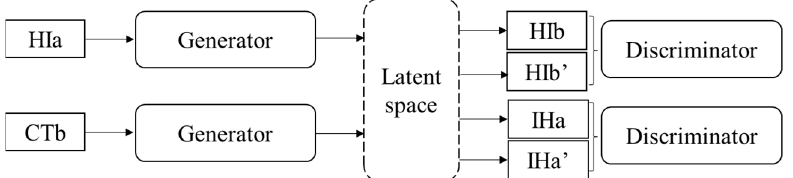
Figure 12. The architecture of XNet. HIa and CTb refer to a halftone image and a continuous-tone image, respectively, as the input of this network. Correspondingly, HIb, HIb’, IHa, and IHa’ refer to the reconstructed images with different styles through different paths.